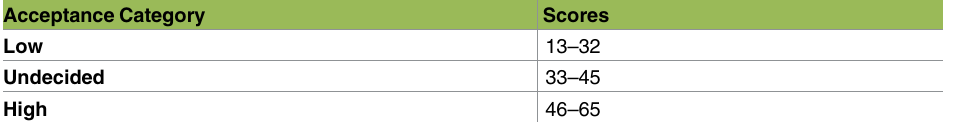
Table 5. Categorisation of evolution acceptance.